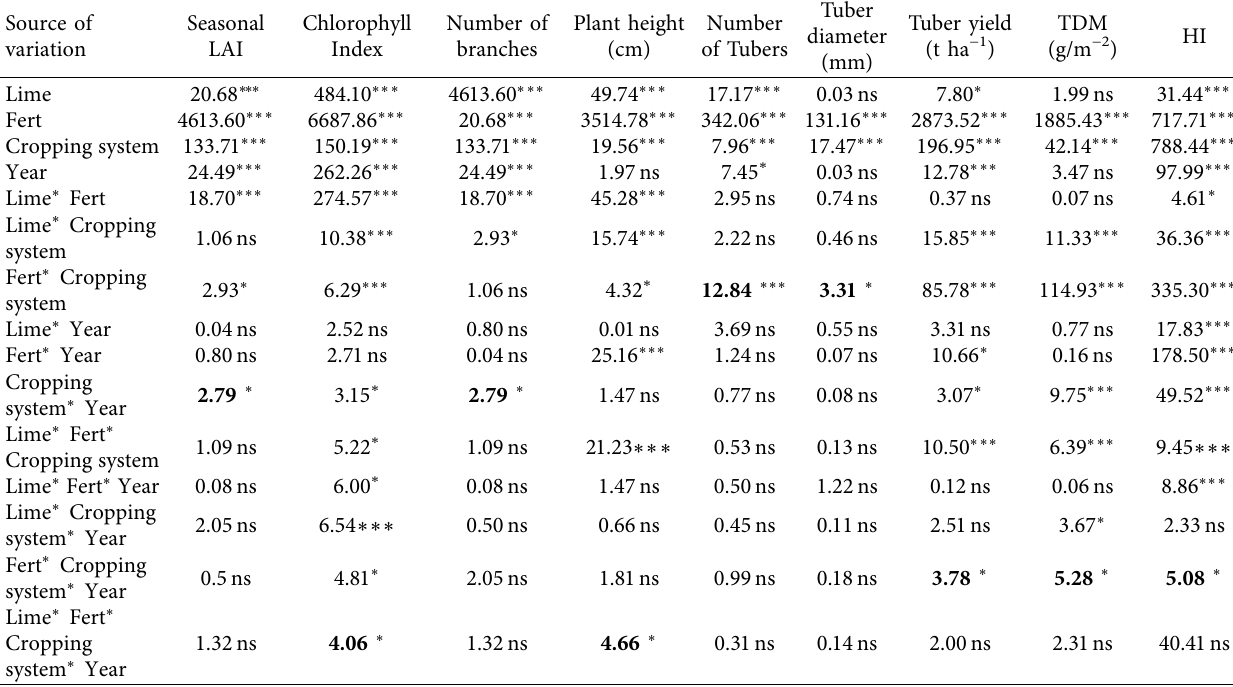
Table 2: Analysis of the variance for lime, fertilization, cropping systems, and year effects, and their on interaction effects on yield, and physiological and morphological plant traits. Source of